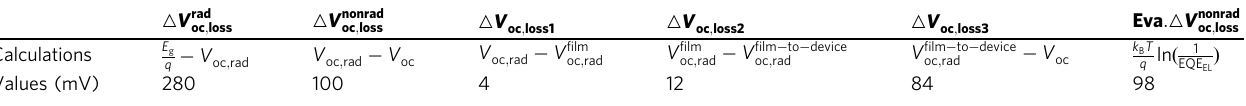
Table 1 A list of common voltage losses of the target PPV